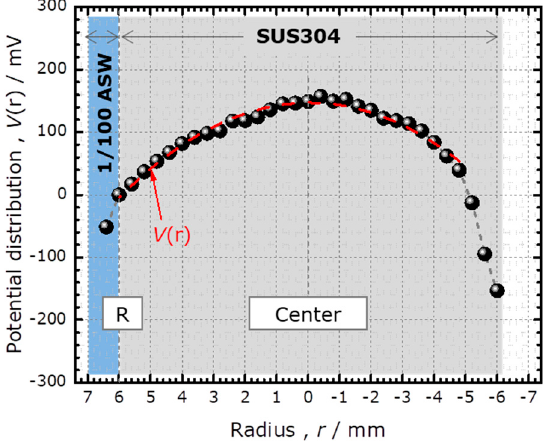
Figure 6. The fitting of the experimentally obtained potential distribution V ( r ) with a parabola.